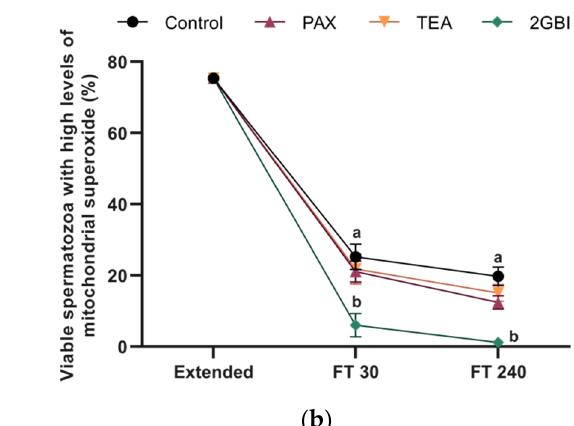
1 ( n = 8), TEA, PAX, and 2-GBI blockers were added to LEY medium at 15 ◦ C ( a ), whereas in Experiment 2 ( n = 9), they were